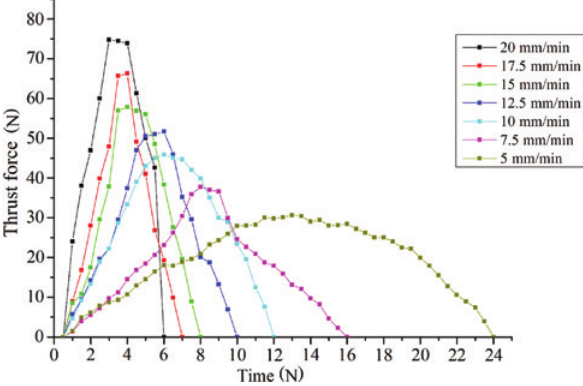
Figure 6: The representative variation of thrust force with time of the DLC drill at a certain condition (3000